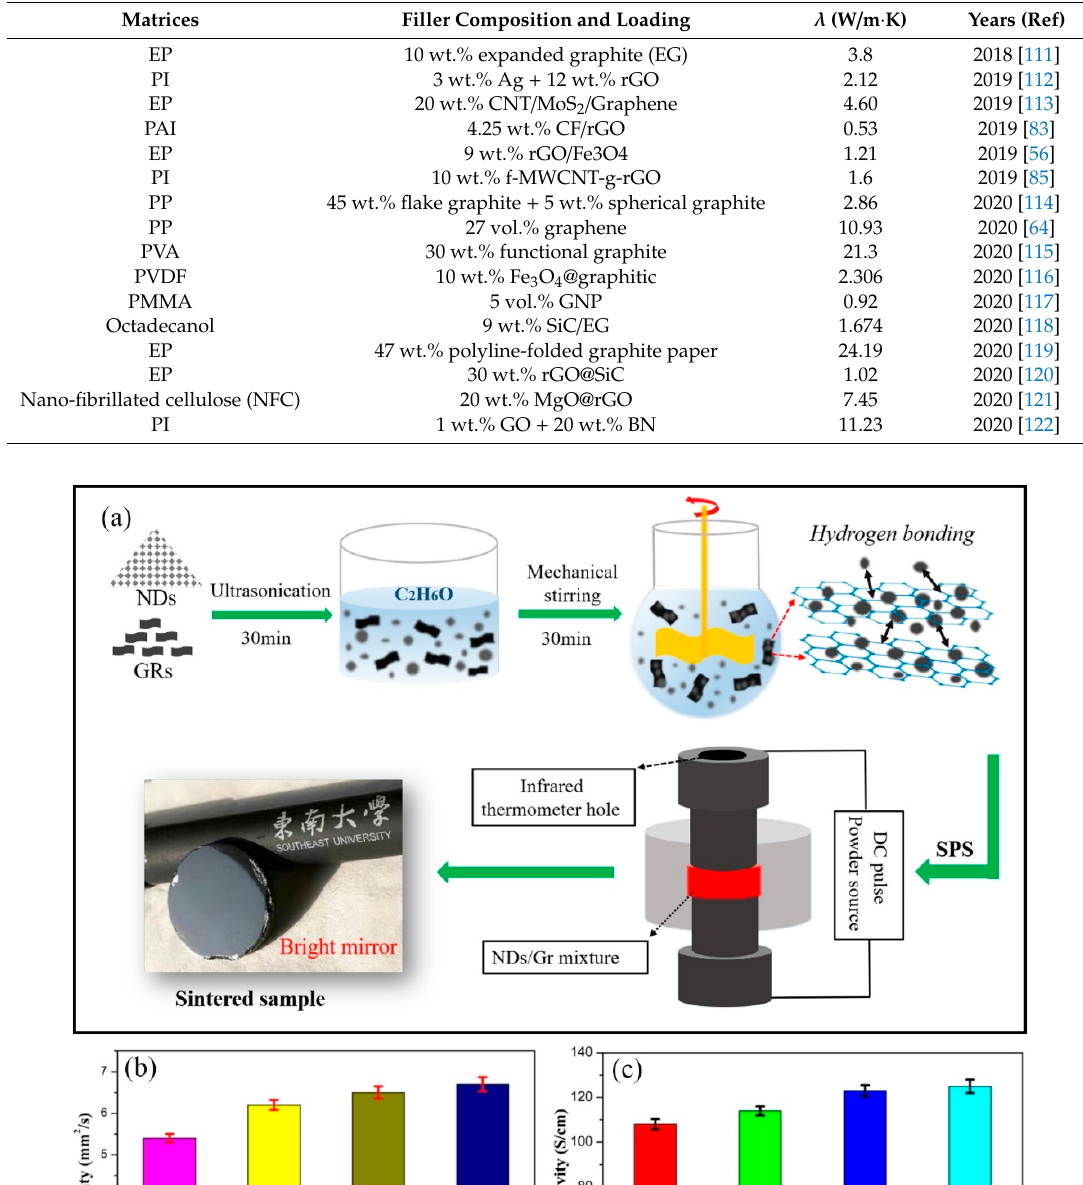
Table 2. λ of graphite and its derivatives / polymer composites.